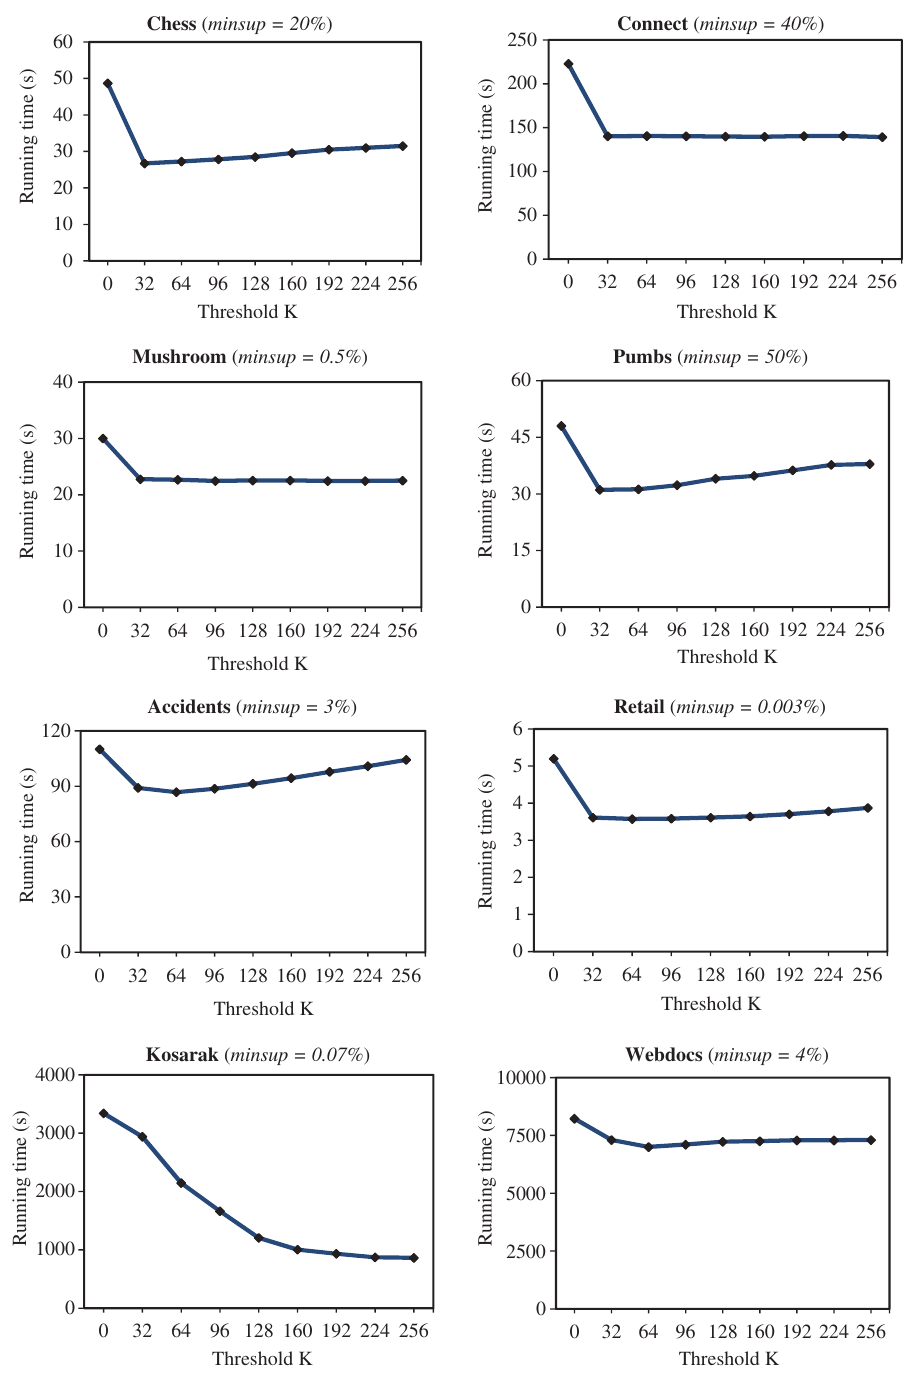
Figure 8. Running Time of FEM with Different Values of K